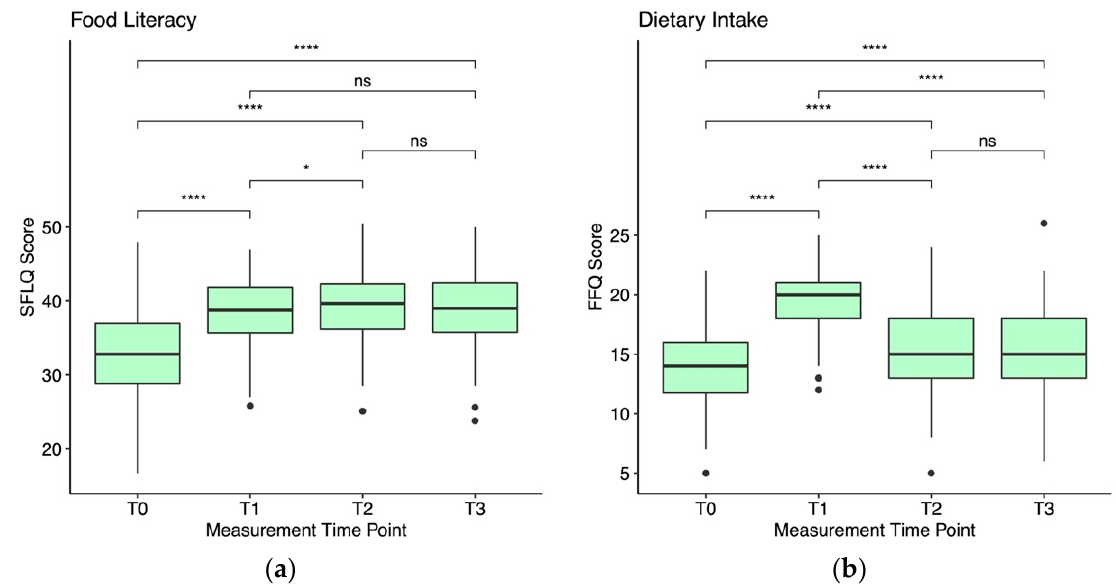
Figure 1. ( a ) shows standard box blots for FL scores measured by the SFLQ for each measurement time point. ( b ) shows standard box plots for DI scores measured by the FFQ for each measurement time point. Significance levels are denoted as ns: p > 0.05, *: p ≤ 0.05, ****: p ≤ 0.0001.